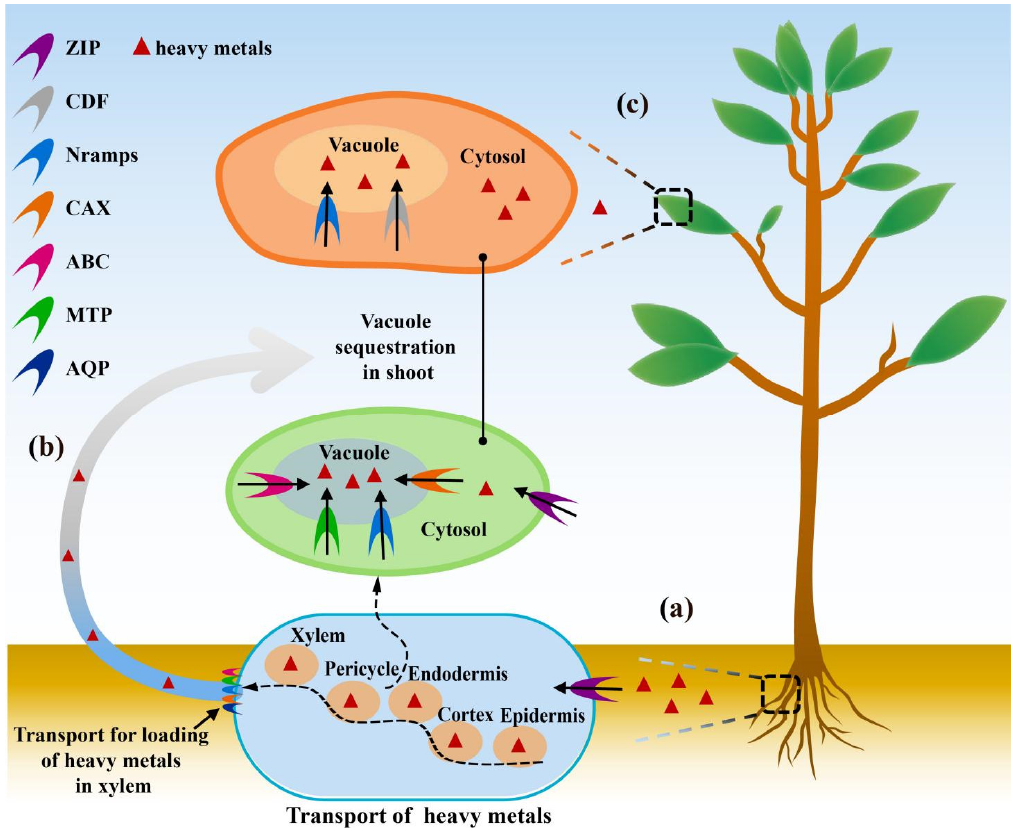
Figure 1. The role of transporters in plant responses to HMS. ( a ) Absorption of HMs in the roots by Zrt/Irt-like protein (ZIP). ( b ) Transport and loading of HMs from root to shoot, and their sequestration in vacuole as accomplished by various transporters such as ATP-binding cassette (ABC), cation/proton exchanger (CAX), natural resistance-associated macrophage protein (NRAMP), metal tolerance protein (MTP), and aquaporin (AQP). ( c ) Vacuolar sequestration of HMs in leaves by cation/proton exchanger (CDF) transporters.